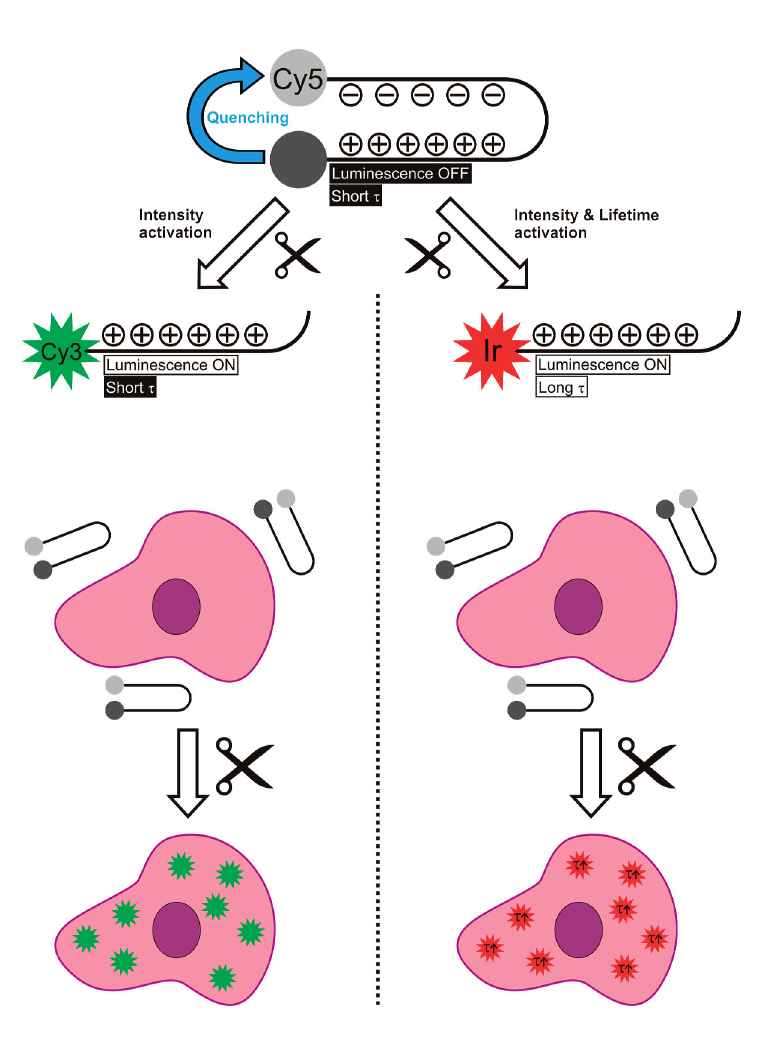
Figure 1. Schematic overview of the difference between the use of an activatable luminescence imaging agent ( left ) and an activatable lifetime imaging agents ( right ), both based on a hairpin motive. It is important to note that in the case of lifetime activation not only the intensity increases, but also the lifetime. This gives two parameters to follow the activation